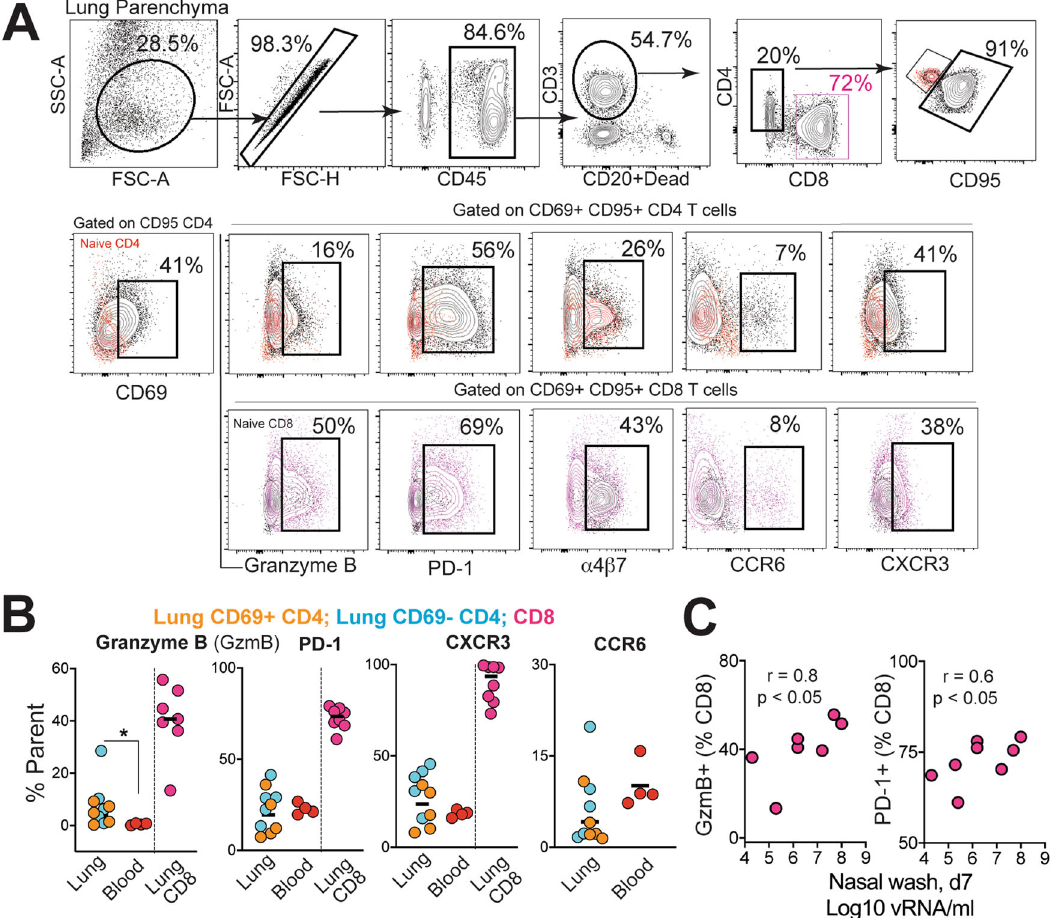
Fig. 6 Induction of T h 1 CD4 effectors in the lungs during SARS-CoV-2 infection. A Gating strategy for identifying CD95 + CD69 + CD4 and CD8 cells expressing granzyme B, PD-1, α 4 β 7, CCR6, and CXCR3. Fluorochromes used were CD45-A488, CD3-A700, CD20/Dead-APC-Cy7, CD8-BUV 805, CD4- BV650, CD95-BUV737, CD69-BV711, Granzyme B- BV421, PD-1-Pe Cy7, a4b7-PE, CD25-APC, CCR6-PECF594, CXCR3-BV786. B Percentage of CD4 and CD8 T cells expressing granzyme B, PD-1, CXCR3, and CCR6 in lung and blood (* p = 0.02 using a two-tailed Mann – Whitney U test). C Correlation plot of vRNA from nasal washes and either granzyme B (GzmB) or PD-1 in CD8 T cells (one-tailed Pearson test p values